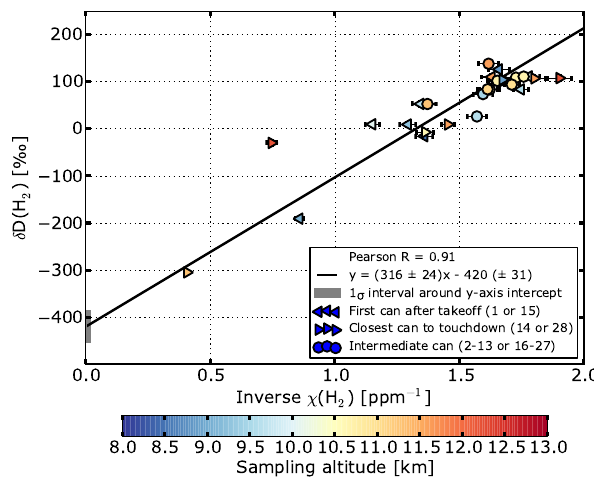
Fig. 3. Keeling plot ( δ D vs. inverse χ( H 2 ) ) for those samples that were labeled as polluted with the iterative selection procedure. The solid line is a linear fit through all the data with the “Williamson- York” (W-Y) algorithm that takes the variance and the estimated errors in both the x- and y-direction into account (Cantrell, 2008). The 1 × SEM (standard error) interval around the axis intercept of the fit is indicated in grey on the vertical axis. The marker type indicates in which part of a flight the sample was taken; the marker color indicates sampling